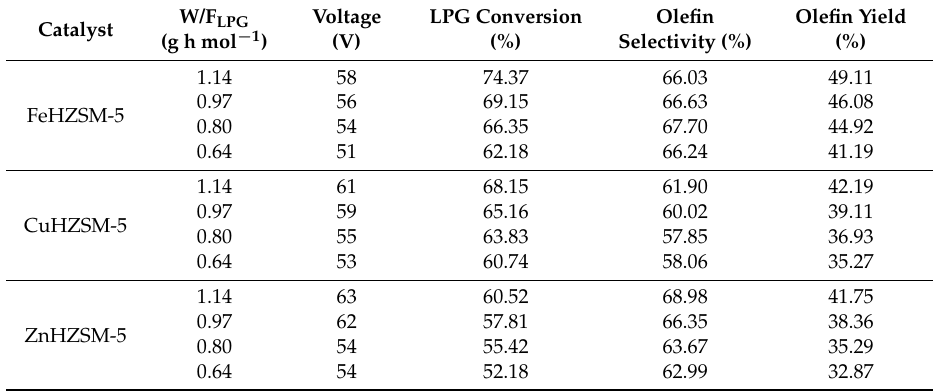
Table 6. Effect of W/F LPG on catalytic activity for FeHZSM-5, CuHZSM-5 and ZnHZSM-5 catalysts: 6 mA electrical current, 10 mm gap distance and 4 wt. % metal loading.